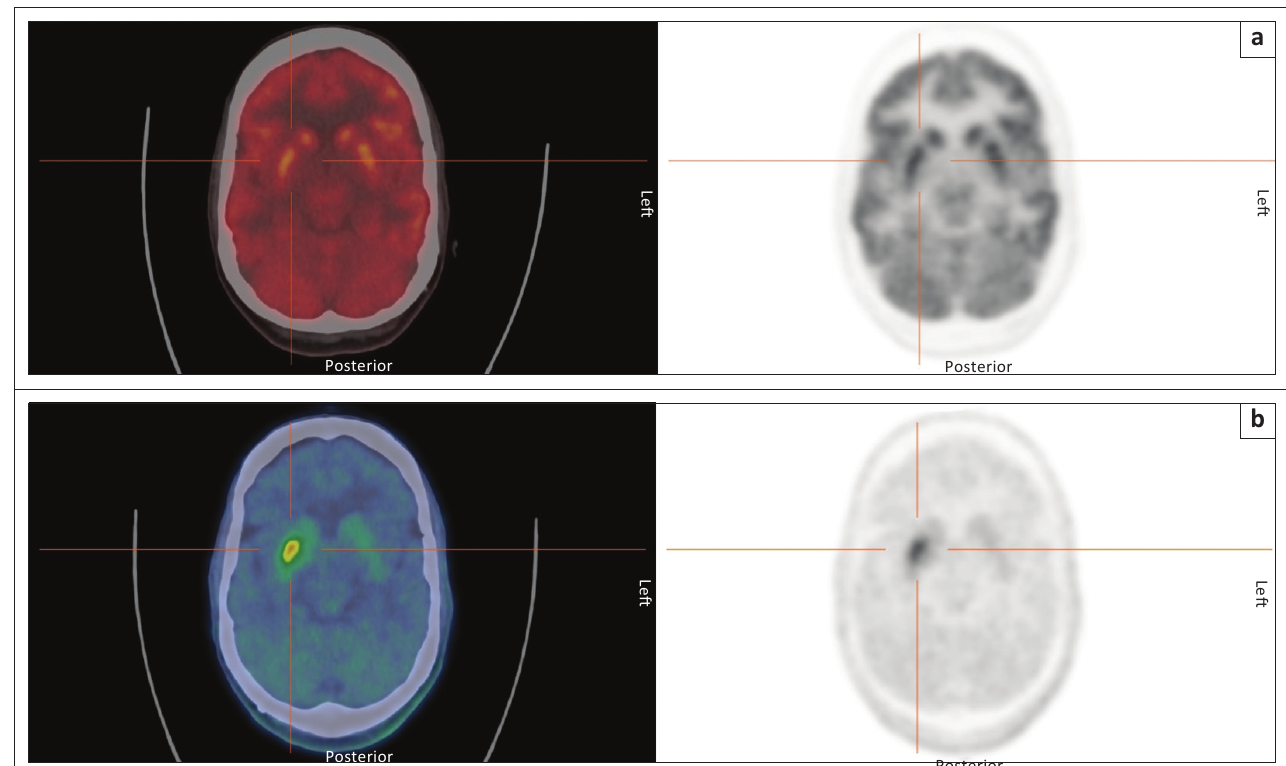
FIGURE 6: Fluorine-18 FDG (a) and FDOPA (b) PET-CT (fusion) and PET images of a patient with suspected recurrence of a low-grade glioma. The FDG PET-CT study was normal, while FDOPA PET-CT (preferred) demonstrates clear recurrence in the right putamen. This recurrent lesion was initially missed on